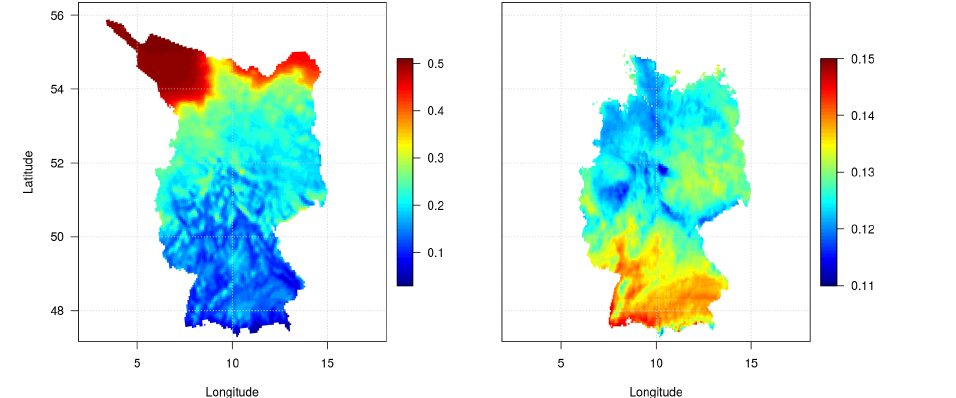
Figure 3. Average capacity factors for wind (left) and photovoltaics (right) in Germany and Germany’s Exclusive Economic Zone (1995–